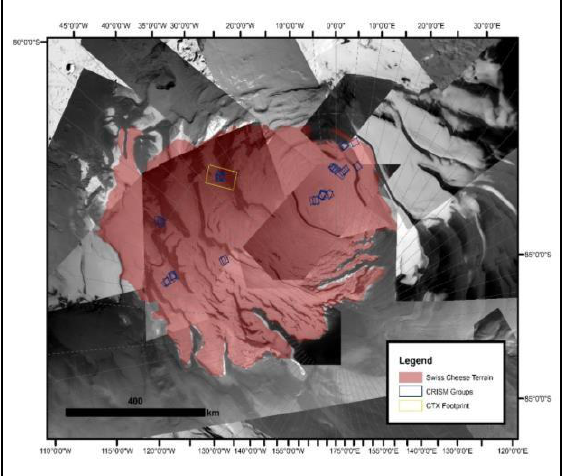
Figure 4: The Martian South Pole; the ba se map is comprised of HRSC (ND3 and ND4) images, with a resolution of 12.5m/pixel. The images were manually co-registered using ArcMap. The area outlined in rose covers regions where SCT is visible in HRSC images. Overlaid are (1) an example of a CTX footprint, which is used to provide a higher resolution (6m/pixel) image of SCT (the yellow rectangle), and, (2) the 13 CRISM groups being used for SWIR spectral analysis (the blue rectangles).